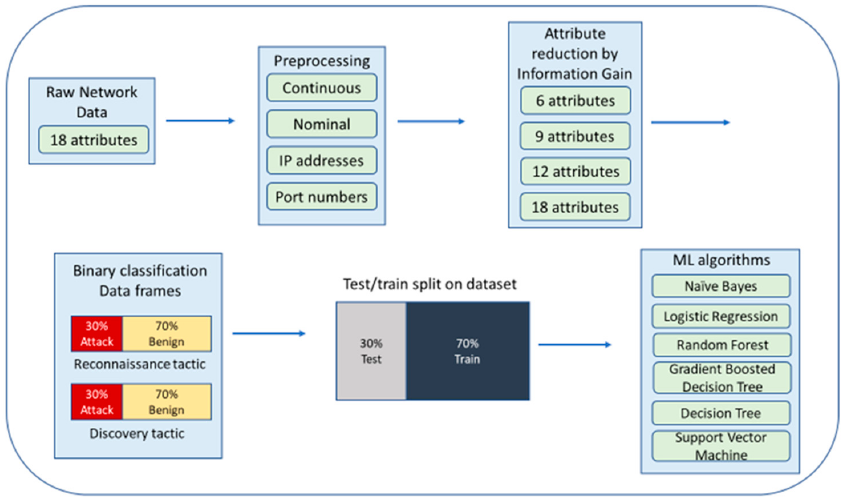
Figure 5. Experimental